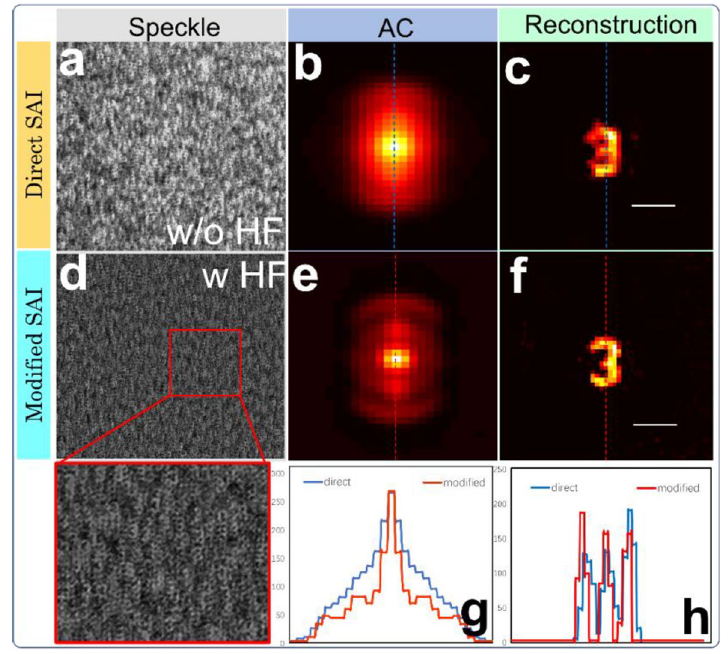
Fig. 5 Modified SAI reconstruction inspired by self-imaging. Experimental results of imaging through a thin diffuser using ( a-c ) classic SAI (Ref. [25]) and ( d-f ) improved SAI reconstruction methods. ( a ) Speckle for reconstruction. ( b ) Autocorrelations of speckle in ( a ). ( c ) The recovered image using the direct SAI method. ( d ) Image of speckle in ( a ) after homomorphic filtering processing. ( e) Autocorrelations of speckle in ( d ). ( f ) The reconstructed results using ( d ) and ( e ). Scale bars in ( c, f ): 10 pixels. ( g, h ) The cross-line plots of the intensity of direct SAI (first row) and modified SAI (second row) at the central vertical line position (shown as the colored-dashed vertical line in ( b-c ) and ( e-f )). AC: autocorrelation. HF: homomorphic